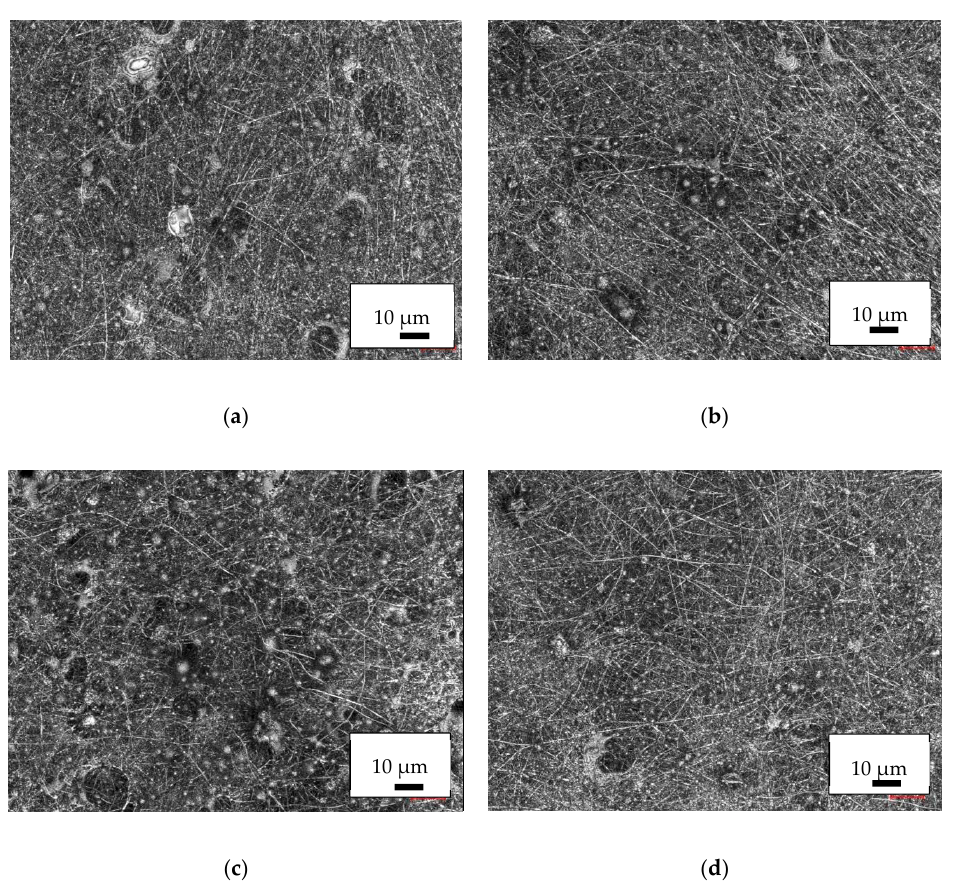
Figure 6. CLSM images of the PAN/diiron nickel tetraoxide nanofiber mats with different polymer:nanoparticle weight ratios: ( a ) 1:0.38; ( b ) 1:0.79; ( c ) 1:1.25; ( d )